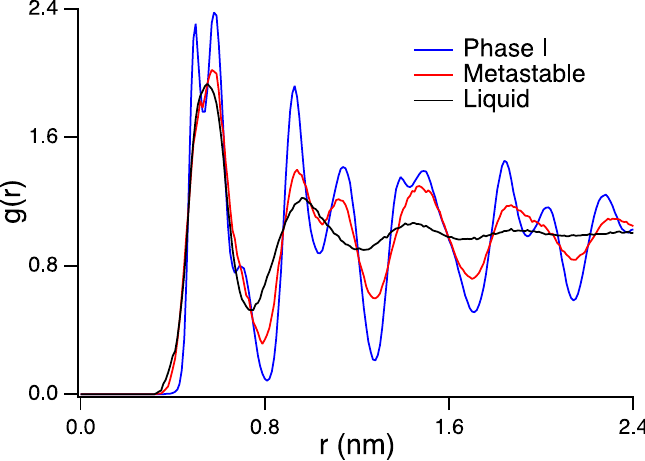
Figure 4. RDFs, g(r), of the COM of benzene molecule for phase I, metastable phase, and liquid phase, computed in the time range 100–150 ps, 490–510 ps, and 9000–9050 ps, respectively.